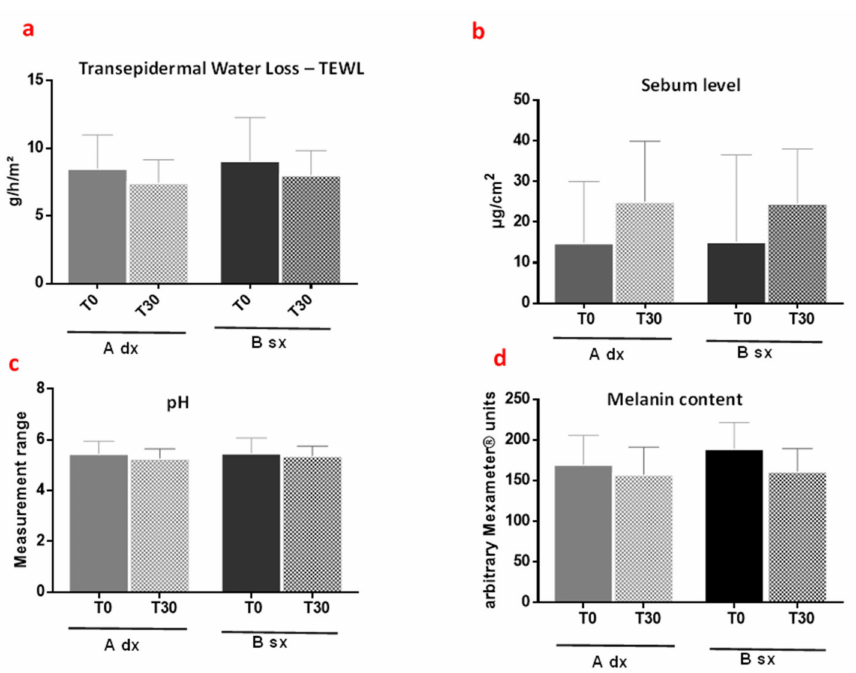
Figure 10. Changes in skin parameters measured (( a ), TEWL; ( b ), Sebum; ( c ), pH; ( d ), melanin content) after thirty days of application of A and B. Results shown are mean ± SD of three deter- minations for each volunteer at different measurement times. Data were analyzed by two-way RM (repeated measures) ANOVA (analysis of variance), followed by a Bonferroni adjustment. Data were significant different p value <